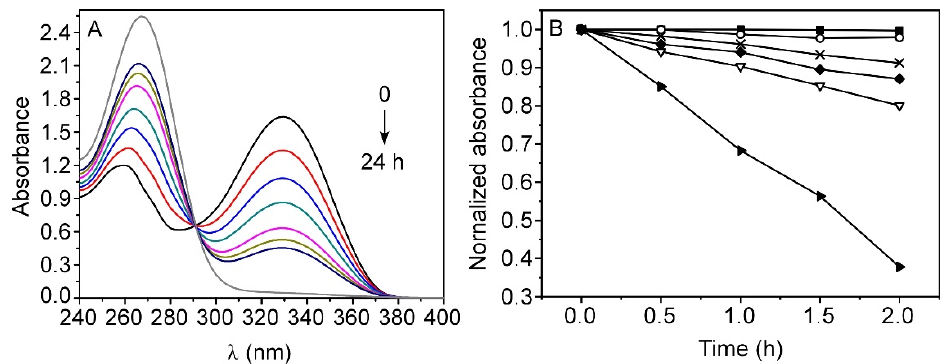
Figure 1. ( A ) Absorption spectra of temozolomide (TMZ) in phosphate buffer pH 7.4 at 37 °C as a function of time up to 24 h. ( B ) Time-dependent degradation of TMZ represented as normalized absorption at major peak (329 nm), under different conditions: acetate buffer (pH 5.0) at 25 (black square) and 37 °C (cross), water at 25 (circle) and 37 °C (triangle) and sodium phosphate buffer pH 7.4 at 25 °C (black diamond) and 37 °C (black triangle).